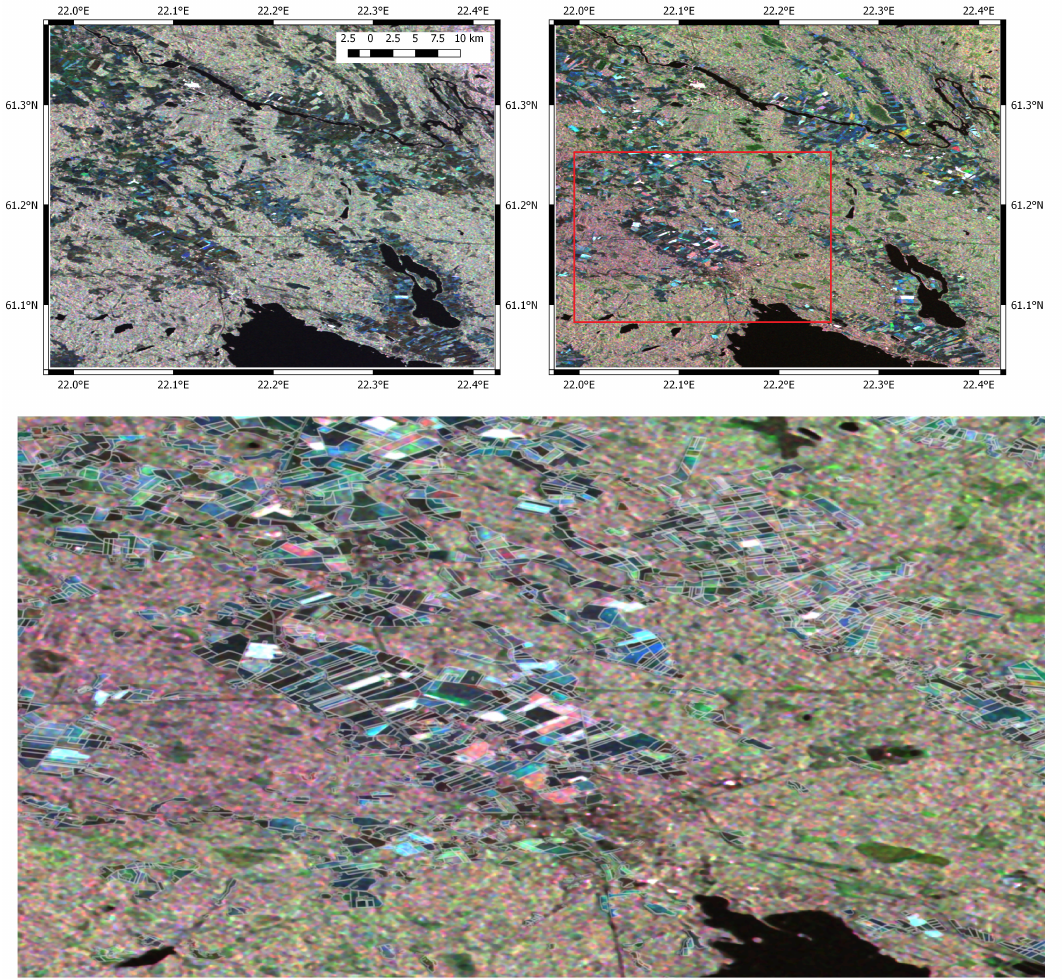
Figure 2. An example of multitemporal Sentinel-1 colour composition, upper left image, Red, Green. Blue (RGB) composite of scenes acquired on 1 June (R), 7 June (G) and 13 June 13 (B); upper right image—RGB composite of scenes acquired on 25 July (R), 6 August (G) and 12 August (B); bottom image is the enlarged fragment of the upper right image showing the parcel boundaries in white color. The backscatter coefficient of VH polarization of each scene is